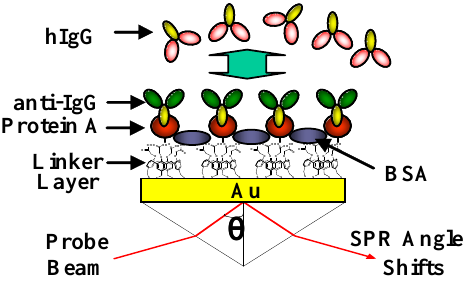
Figure 3 . Schematic diagram of protein-protein interaction between hIgG and anti-hIgG on Cal-4 linker system confined Au